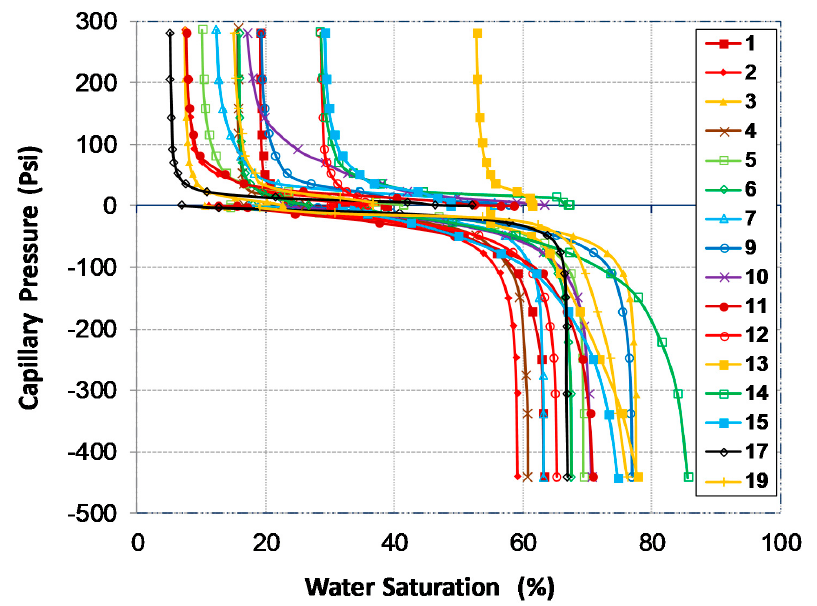
Figure 2. The measured forced displacement capillary pressure curves for 16 samples studied here.